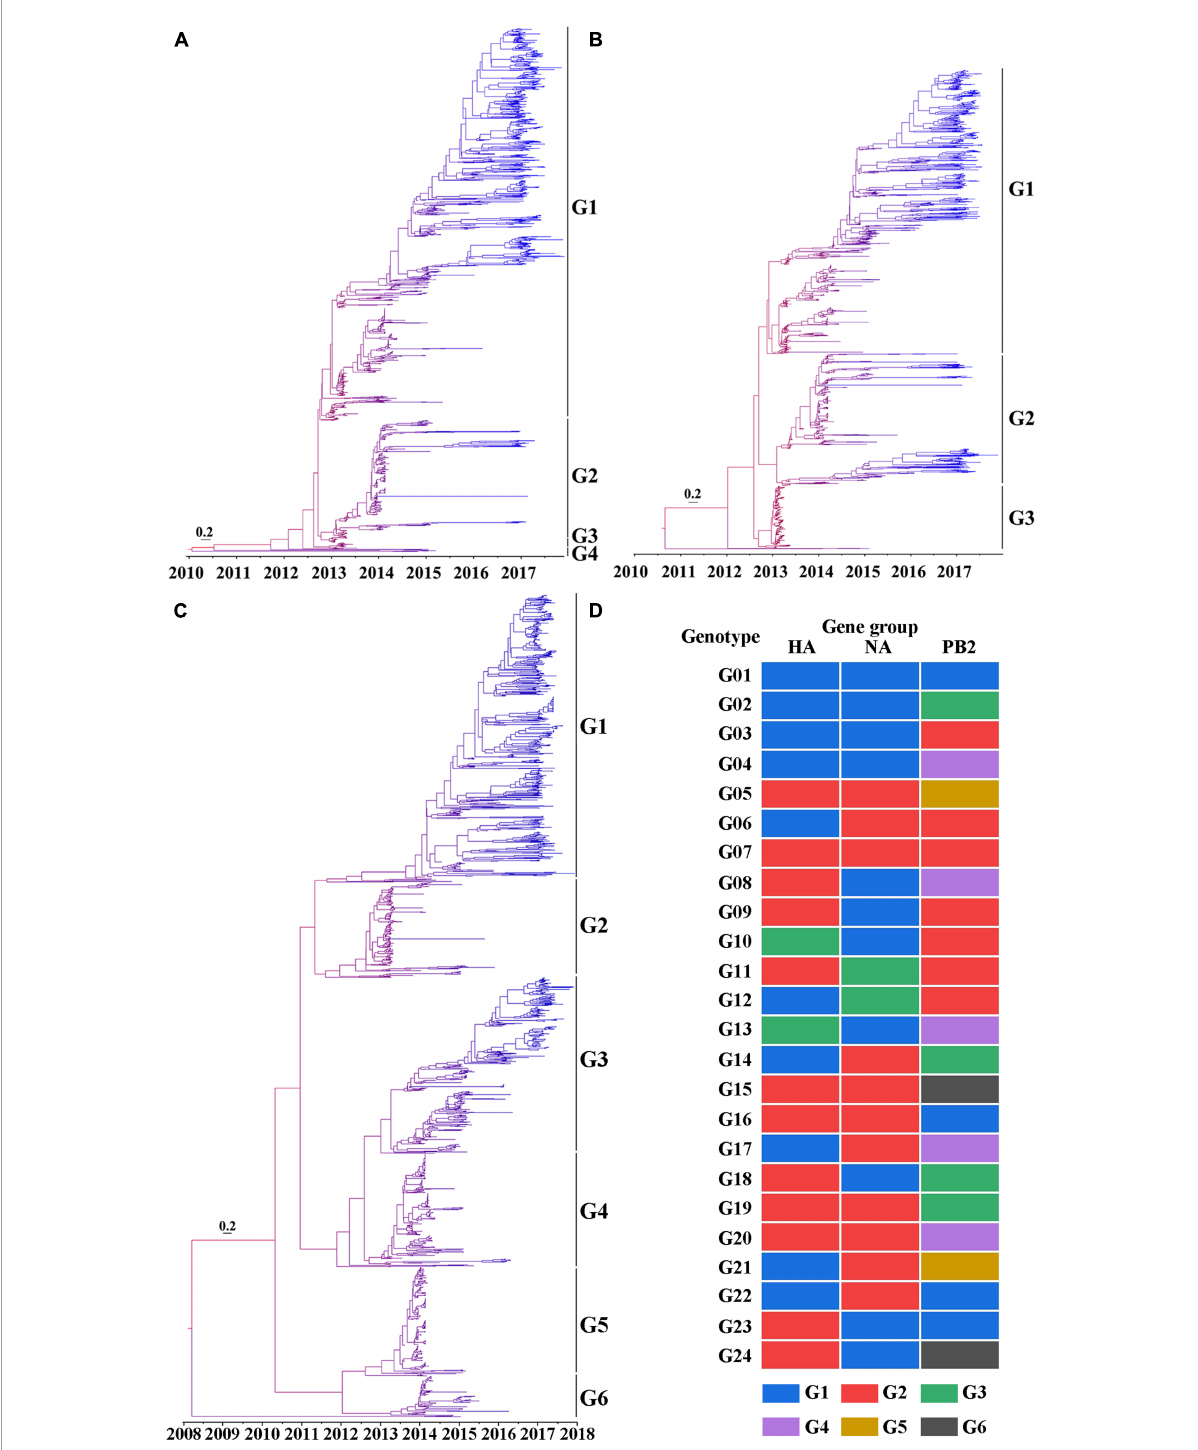
FIGURE3 Phylogeny of the H7N9 viruses. (A) The maximum clade credibility (MCC) tree based on the HA nucleotide sequences of the H7N9 viruses. (B) The MCC tree based on the NA nucleotide sequences of the H7N9 viruses. (C) The MCC tree based on PB2 nucleotide sequences of the H7N9 viruses. For generating the MCC trees, the gene sequences were aligned by ClustalW in MEGA 6.06. The trees were build using BEAST 1.10.0 based on the spatio-temporal evolution analysis of gene sequences and then were visualized by Figtree 1.4.3. The color of the branches ranges from red to blue representing the tMRCA of the tree root to the most recent strains. Bar represents 0.2 calendar years. (D) Genotypes of the H7N9 viruses classified according to the gene lineages of HA, NA, and